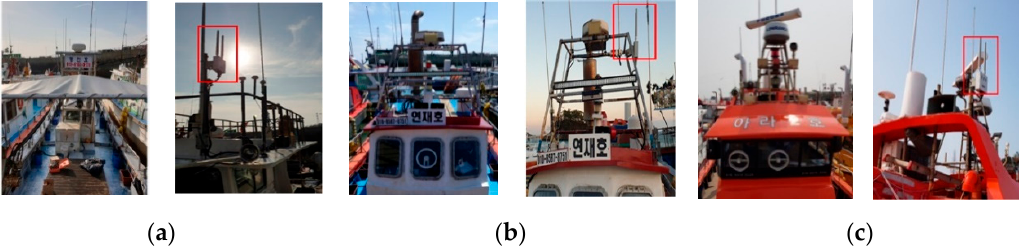
Figure 3. Images of the front portion of each ship used in the real ship test and installed antennas: ( a ) ship A (Gyeonginho), ( b ) ship B (Yeonjaeho), and ( c ) ship C (Ara-2 ho).